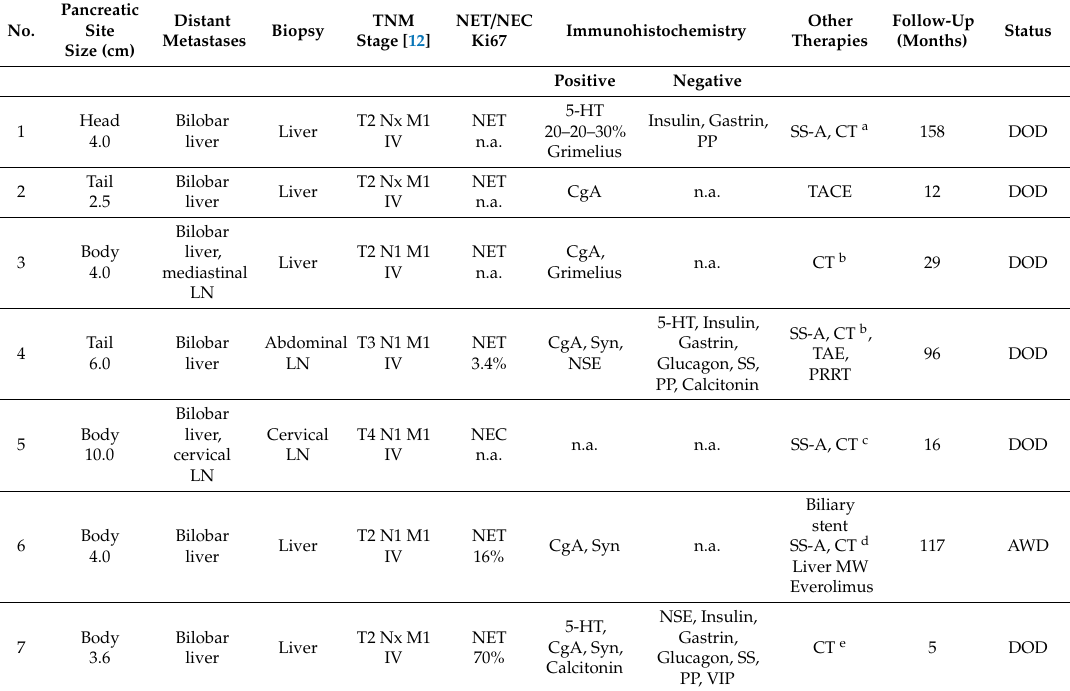
Table 2. Pathological findings and follow-up in patients with serotonin-secreting pancreatic NETs.